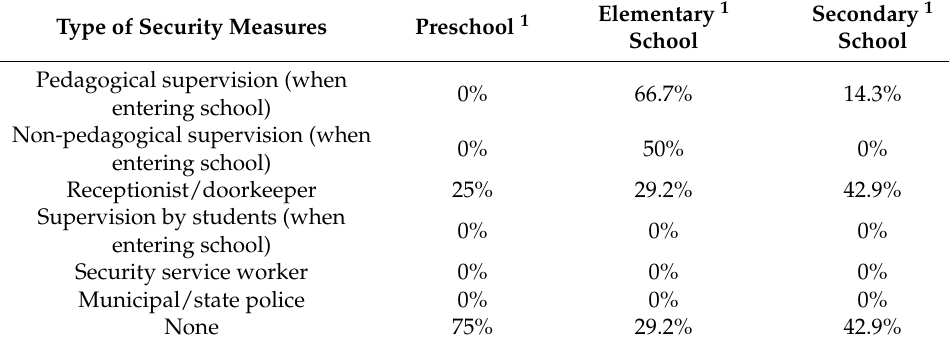
Table 5. School security staffing—percentage of